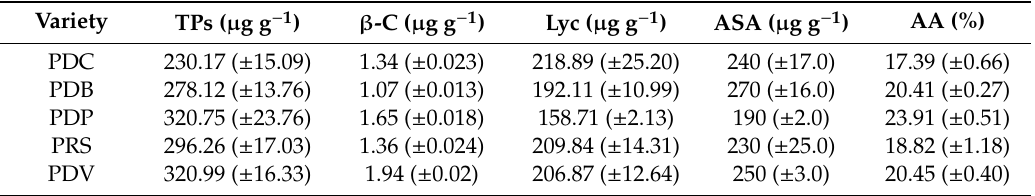
Table 2. Total polyphenols (TPs), β -carotene content ( β -C), lycopene (Lyc), ascorbic acid content (ASA), and antioxidant activity (AA) present in the five landraces of tomato “Piennolo”. The data are shown as average of three independent experiment ( ± SD). Legend: PDC = Piennolo Cento Scocche; PDB = “Piennolo Principe Borghese”; PDP = “Piennolo di Pollena”; PRS = “Piennolo Rosso Vesuviano”; PDV = “Piennolo